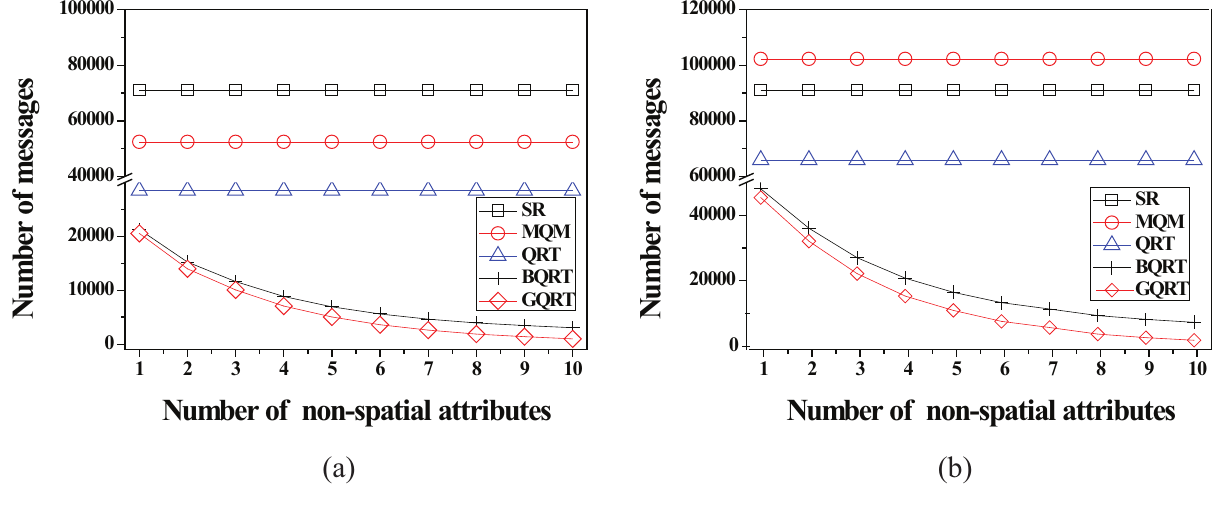
Figure 15. Total number of messages vs . number of non-spatial attributes. ( a ) Uniform ; ( b ) Skewed